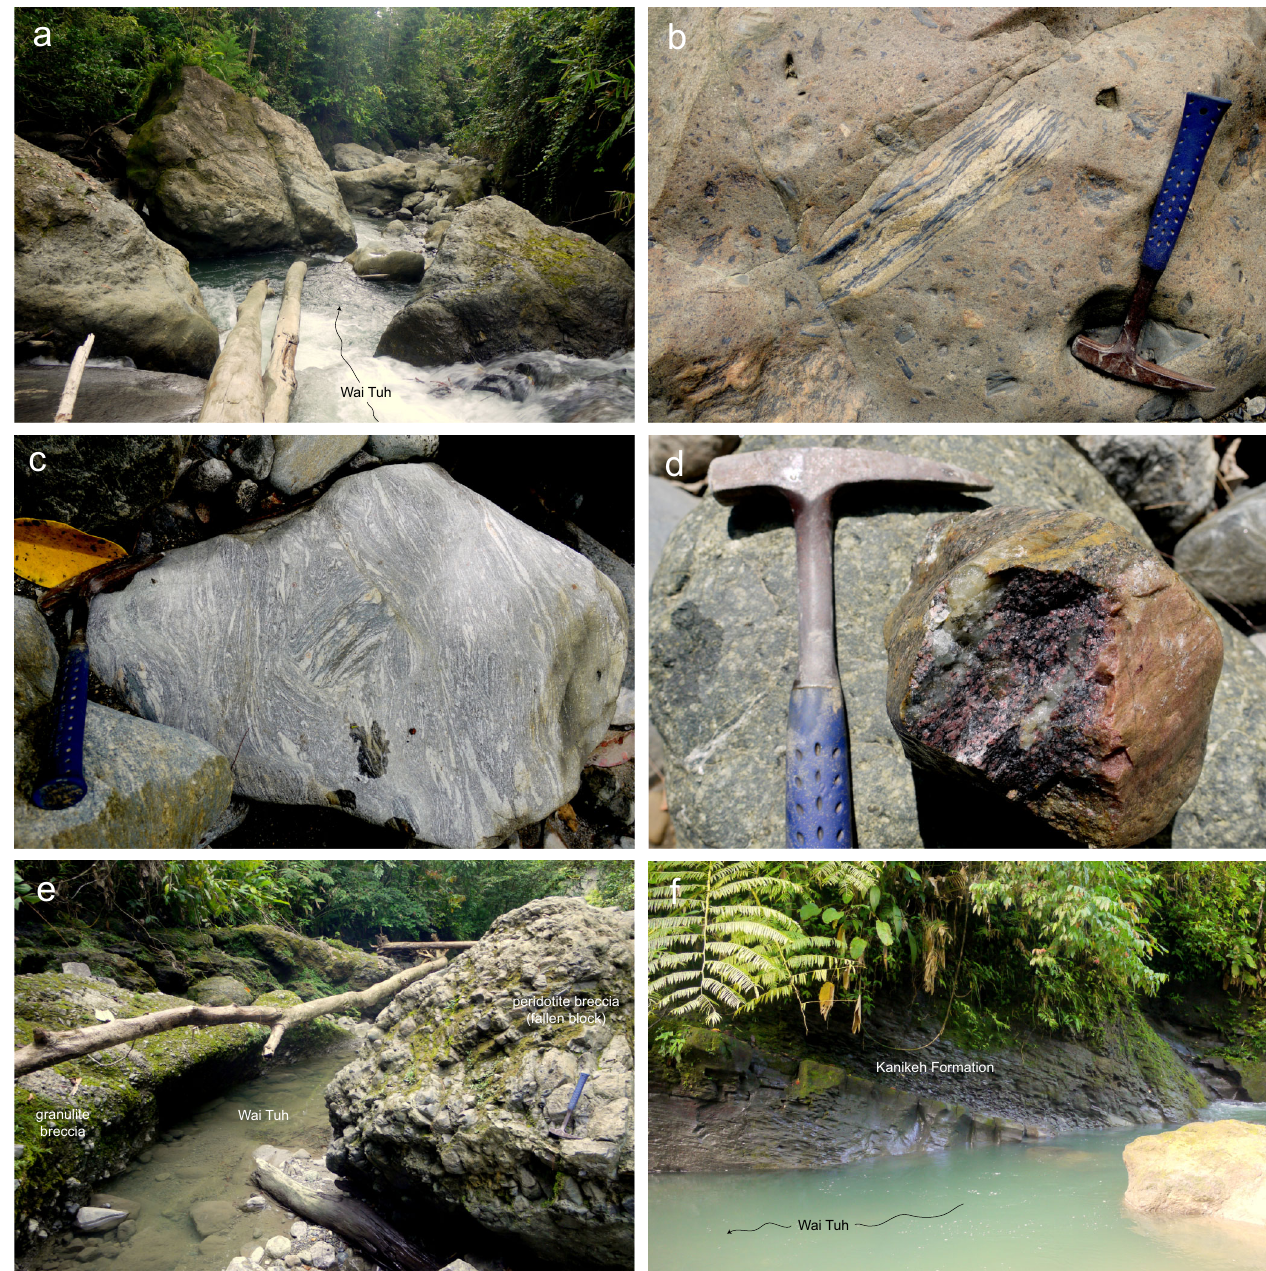
Fig. 17. The Wai Tuh, Kobipoto Mountains. (a) Huge blocks of peridotite breccias collapsed into the Wai Tuh (129.4795 ◦ E, 2.9951 ◦ S); (b) Cordierite granite boulder containing large gneissose granulite schollen and sillimanite-spinel schlieren (129.4798 ◦ E, 2.9994 ◦ S); (c) Metatexite boulder (129.4786 ◦ E, 3.0018 ◦ S); (d) Highly residual garnet-cordierite-sillimanite-spinel-corundum-quartz granulite boulder collected from the Wai Tuh (see Fig. 18a for thin section photomicrograph; 129.4785 ◦ E, 3.0019 ◦ S); (e) In situ breccias of diatexite granulites (left) and block of peridotite breccia (right) (129.4802 ◦ E, 3.0000 ◦ S); (f) Undeformed, gently dipping beds of Kanikeh Formation mudstones of the upstream section of the Wai Tuh, which alternates with granulite breccias as shown in photo (e) (129.4759 ◦ E, 3.0216 ◦